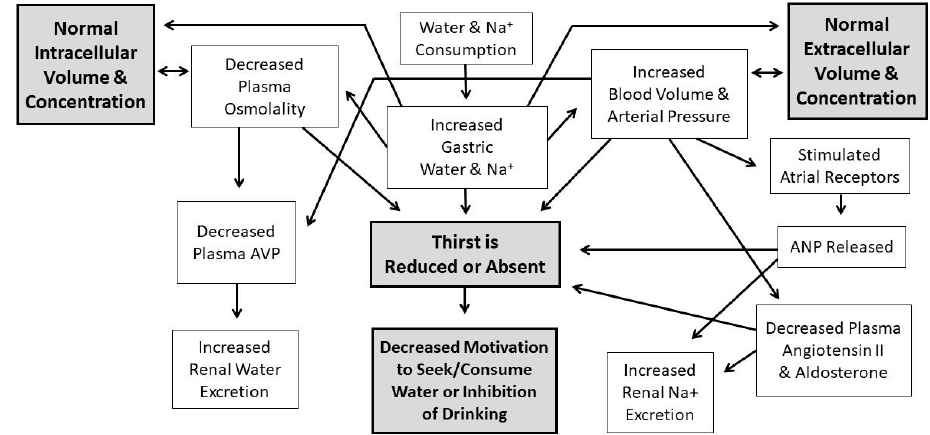
Figure 2. Homeostatic normalization of intracellular hydration, plasma osmolality, blood pressure, and extracellular volume (i.e., due to water and food intake), which result from a persistent, strong motivation to drink. These responses result in reduced thirst and decreased motivation to seek/consume water.